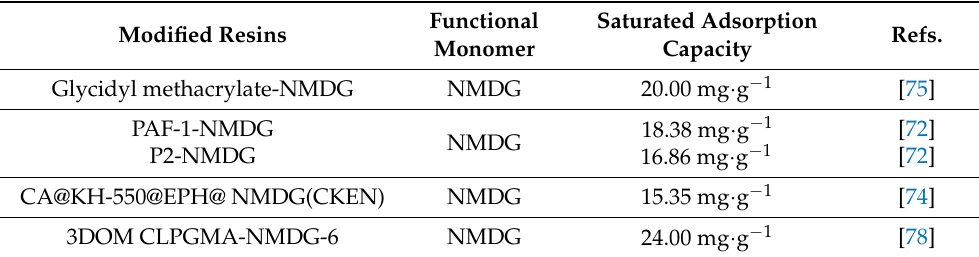
Table 9. Characteristics of several modified resins based on NMDG